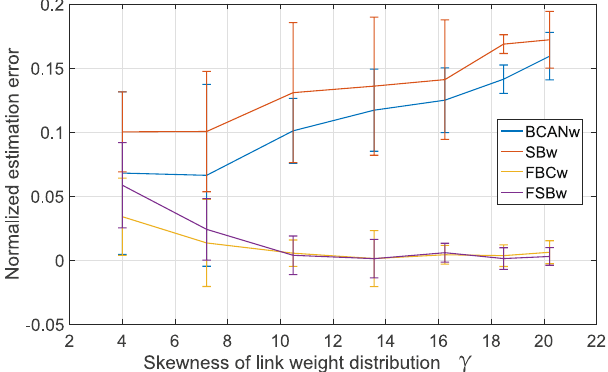
Figure 10. Normalized estimation error of BCANw, SBw, FBCw and FSBw under different skewness γ of link weight distribution by changing the copy factor b of G 5 from 2 to 8. (i) The performance of BCANw and SBw degrade as the γ grows. (ii) BCANw and SBw tend to underestimate the dominant fractal dimension which is aligned with our theoretical prediction in analysis of the staircase effect. (iii) The proposed FBCw and FSBw tends to be insensitive to the change of γ and benefit from the increased size of the target